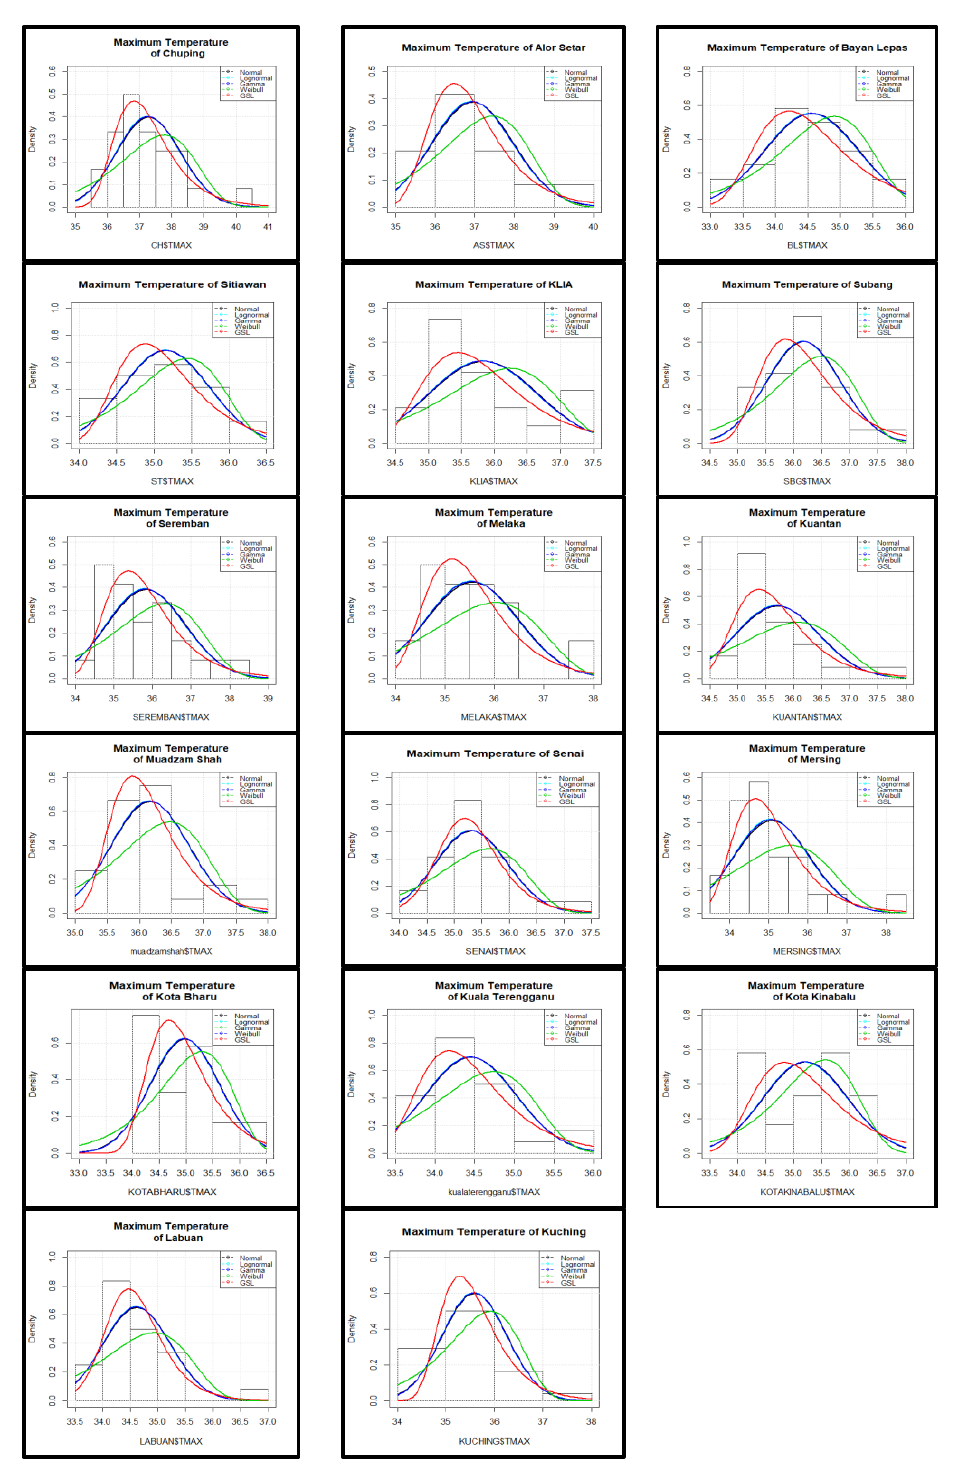
Fig. 1. The graphical comparison between the selected distributions for each